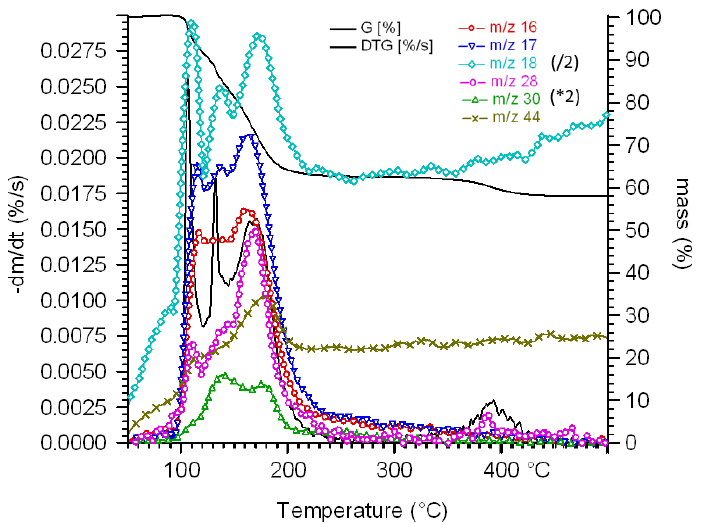
Figure 9. The TG − MS ion curves of compound 1 in an argon atmosphere. Please note that the intensity of the m / z = 18 and 30 is multiplied.